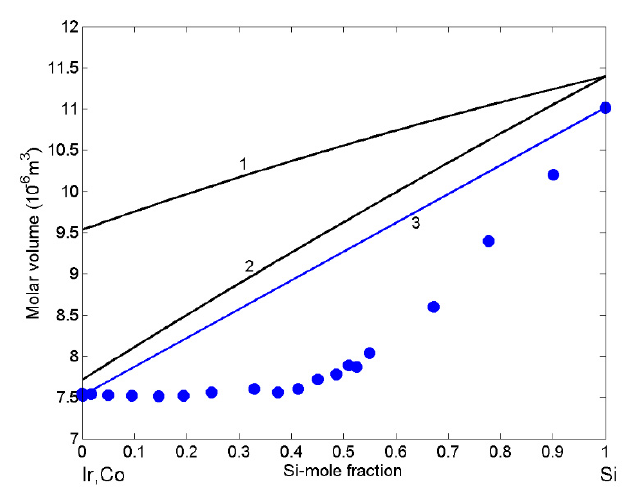
Figure 3. Concentration dependence of the molar volume of liquid Ir-Si (curve 1) and Co-Si (curve 2) alloys calculated for T = 1873 K. For a comparison, the molar volume of Co-Si melts (curve 3) calculated for T = 1773 K together with experimental values ( ) obtained from the density experimental data [60] measured at the same temperature are shown.